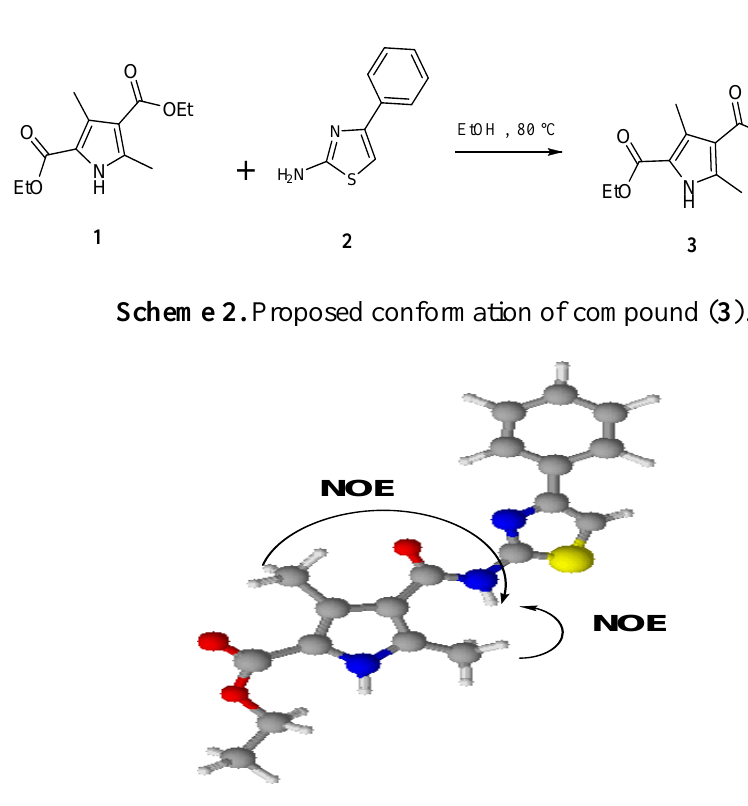
Figure 1. ¹H-NMR spectrum of compound ( 1 ) (400 MHz, DMSO- d